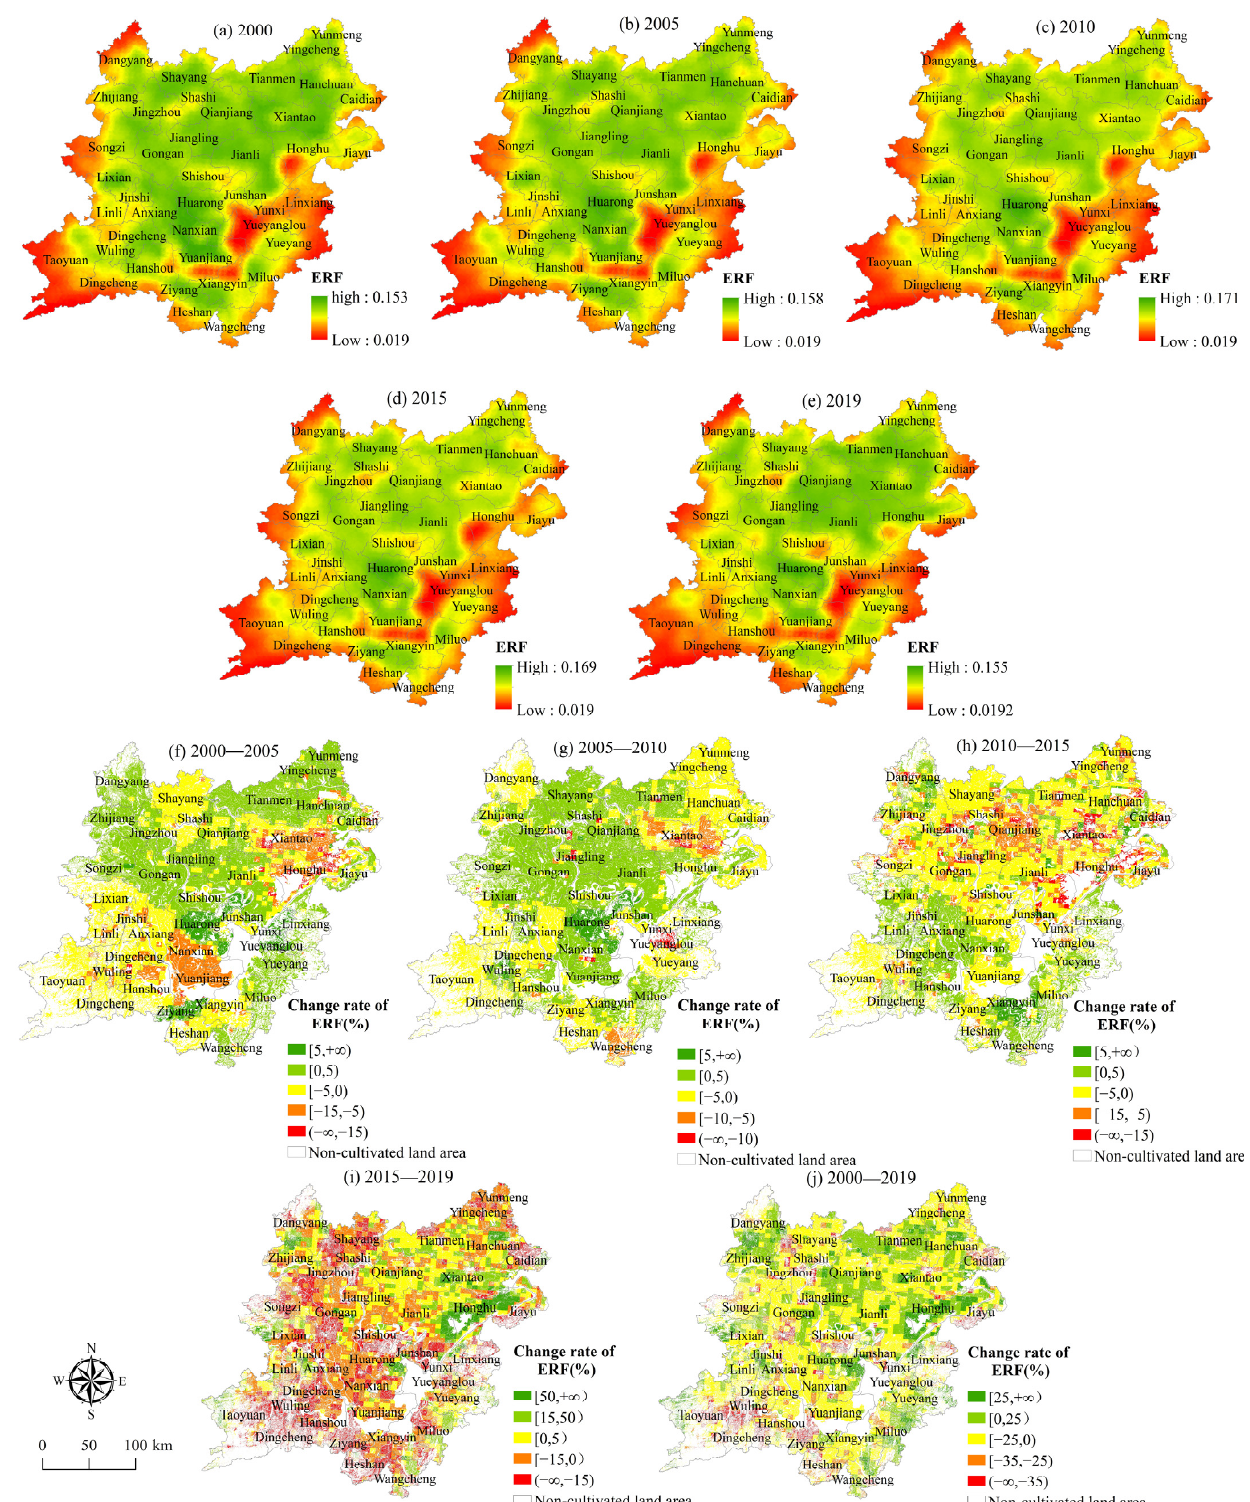
Figure 9. Spatial distribution of ecological regulation function index.